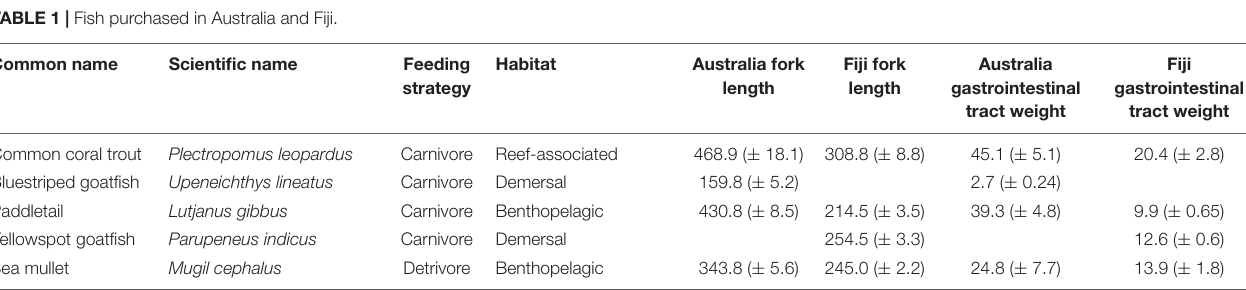
FIGURE 1 | Map of sampling locations in Australia and Fiji. Samples in Australia were fished in the coastal region of Queensland (QLD), and purchased from fish markets in Sydney and Brisbane. Samples from Fiji were fished and purchased locally at the Suva fish markets. TABLE 1 | Fish purchased in Australia and